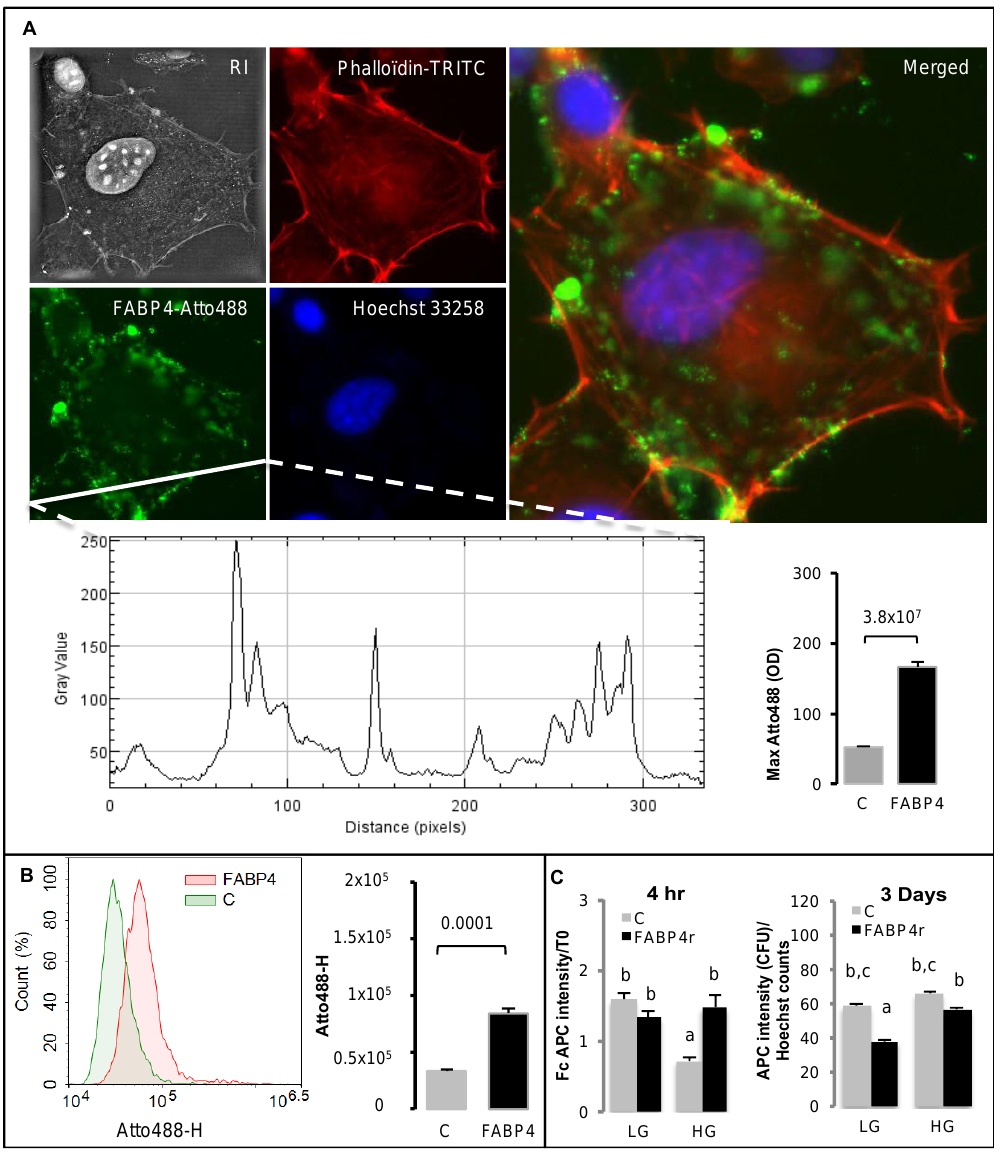
Figure 7. Fatty acid binding protein 4 (FABP4) uptake and regulation of active FAT/CD36 form in 3T3-MBX cells ( A ) Nanolive imaging after 3 h treatment with Atto488-FABP4 (FABP4r 100 ng/mL) and quantification of max Atto488 intensity per cell. ( B ) Atto488-FABP4 quantification by cytometry. ( C ) Effect of FABP4r on extracellular FAT/CD36 detected with APC-coupled anti-FAT/CD36 antibody after 4 h and after 3 days. Data are presented as mean values +/ − SEM (n = 10 cells in A, 8 biological replicates in ( B , C )) with significant differences indicated by Student t -test p -values in ( A , B ), and different letters in ( C ) (Anova test p -values <